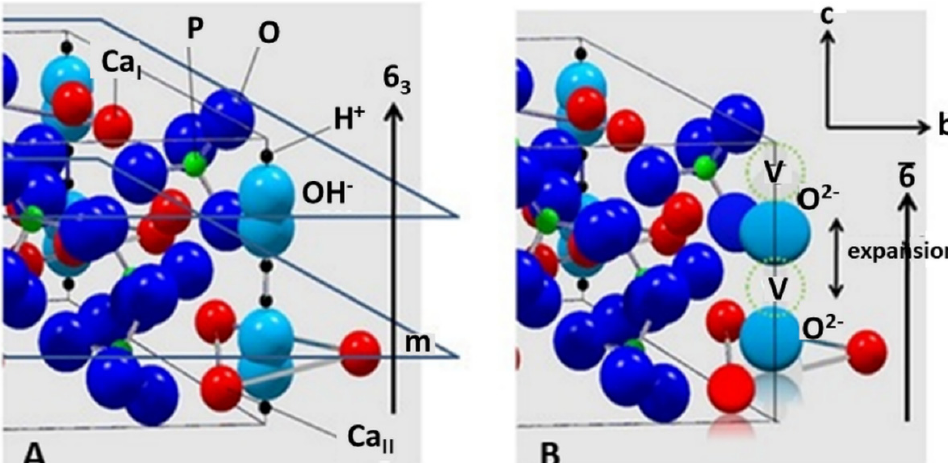
Figure 3. ( A ): Ball-and-spoke model of hydroxylapatite with space group P 6 3 / m . There are mirror planes m through z = 1 ⁄ 4 and z = 3 ⁄ 4 , perpendicular to the c -axis with 6 3 characteristics. The non-equivalent Ca I and Ca II positions are indicated. ( B ): Hypothetical structure of oxyapatite, S.G. P 6. There is a chain of O 2 − ions separated by vacancies V along the polar hexagonal axis 6. © Reprinted with permission from R.B. Heimann, Materialwiss. Werkstofftechn., 2009, 40(1–2), 23–30. Copyright 2009 Wiley.